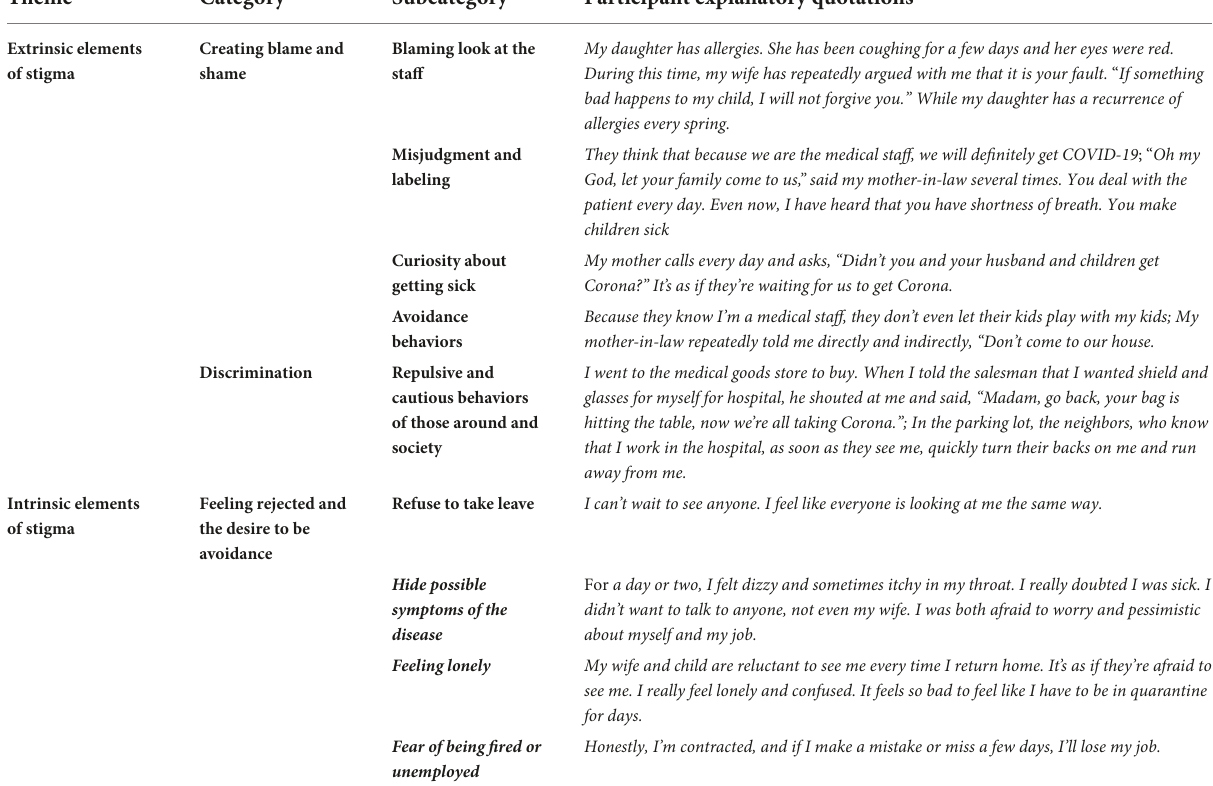
TABLE 2 Themes and their categories related stigma over health care workers related to COVID-19.